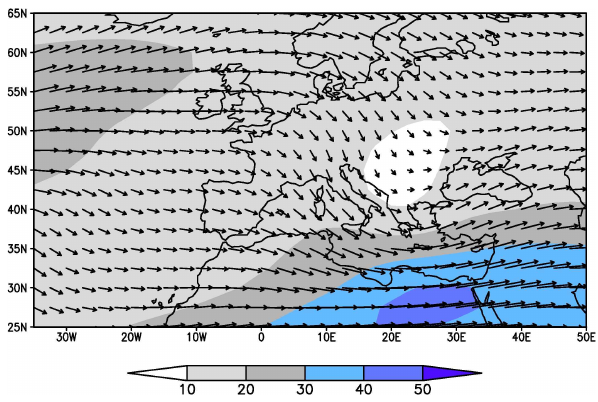
Fig. 7. Composite of wind at 250hPa for the eastern Mediterranean. Values are in m/s.